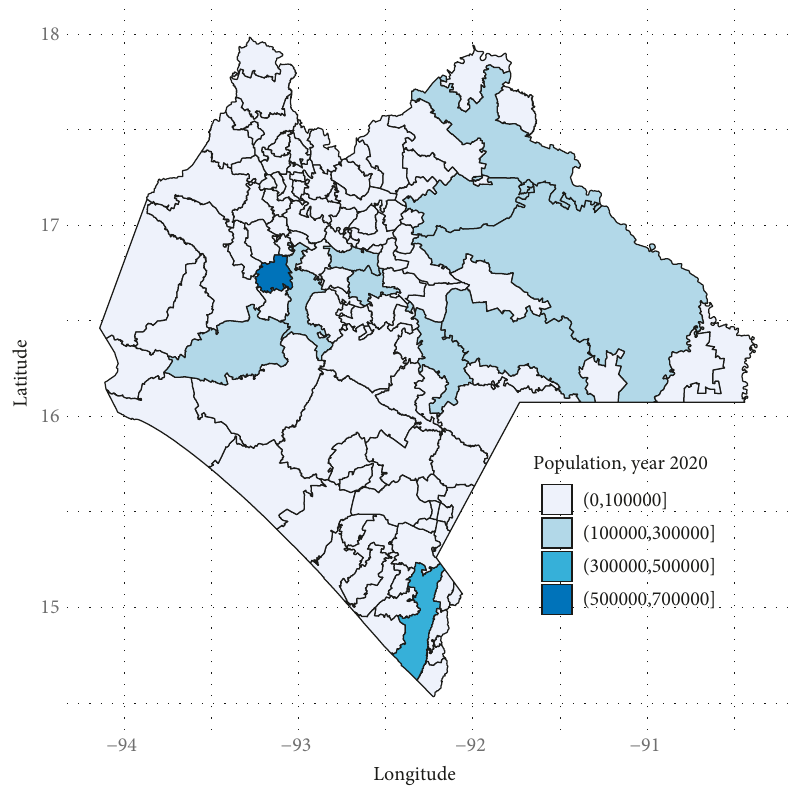
Figure 1: Population distribution of